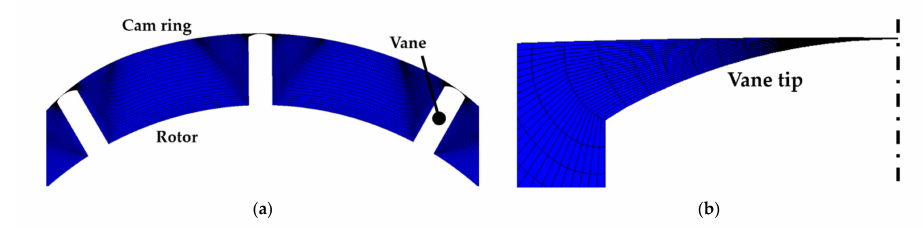
Figure 4. Mesh of the displacement chambers ( a ) and details of the radial gap mesh ( b ) of the BVP.